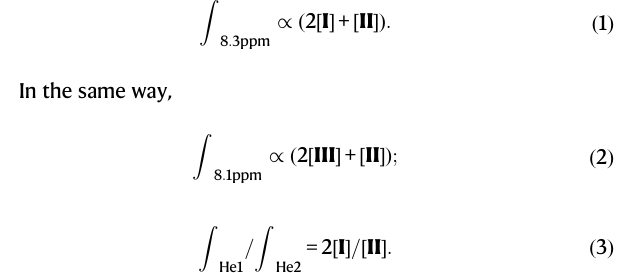
Fig. 3 | Spectral results for a mixture of enantiomeric 1 and 4 . a UV – Vis and CD spectra (chloroform, 25°C) of pR - 1 , pS - 1 , and mixtures of 4 with pR - 1 or pS - 1 . The concentrations of 1 and 4 were 0.05 and 0.1mM, respectively. b Simulated (Sim.) and experimental (Exp.)high-resolution ESI-MS spectraof amixtureof 4 with pS - 1 . c , d Partial 1 H NMR spectra (600MHz, CDCl 3 , 25°C) for as-prepared mixtures of